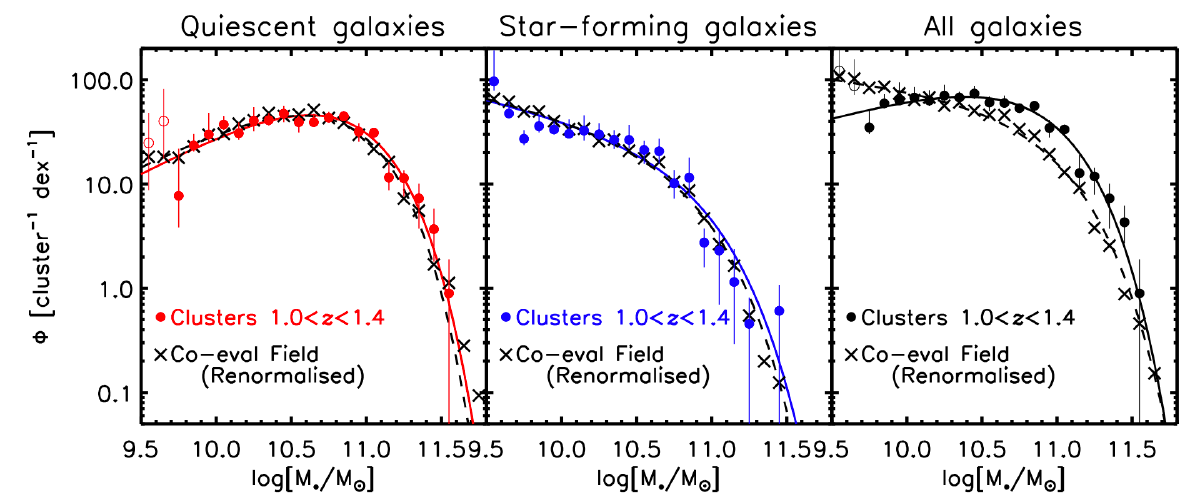
Figure 4. The SMFs of QGs ( left ), SFGs ( middle ), and the total population ( right ) in 11 GOGREEN clusters at 1 < z < 1.4 (circles; [388]). Renormalized field SMFs (crosses) drawn from the COS- MOS/UltraVISTA survey [387] are shown in comparison. For QGs and SFGs separately, the shapes of the SMFs are independent of environment. For the total population, there is an excess of high-mass and a dearth of low-mass galaxies in the clusters. Figure reproduced from Figure 6 in van der Burg et al. [388], with permission from